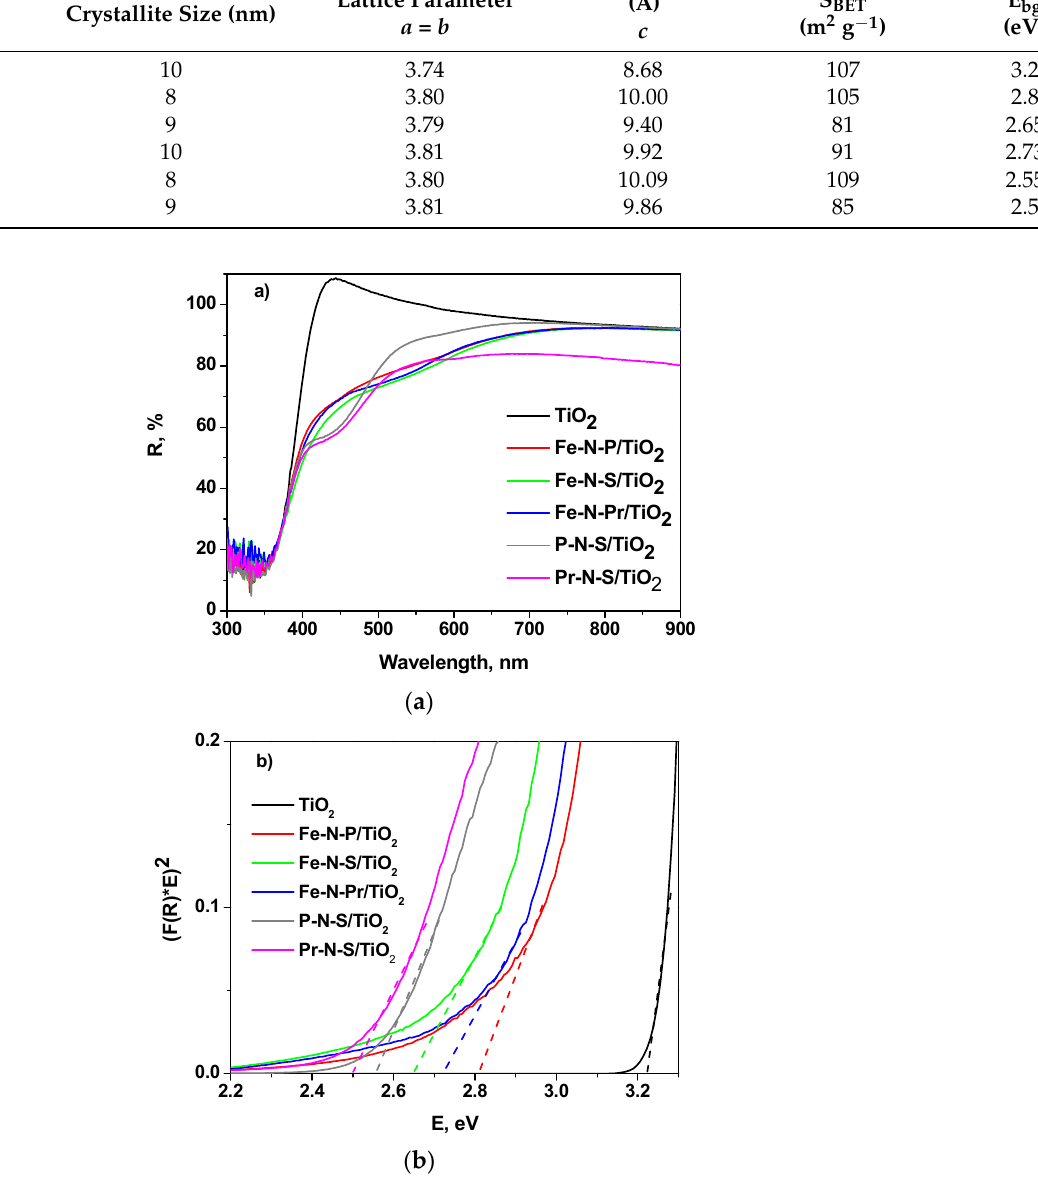
Table 1. Crystallite size, lattice parameters, specific surface area, and band gap data of all prepared photocatalysts. Sample